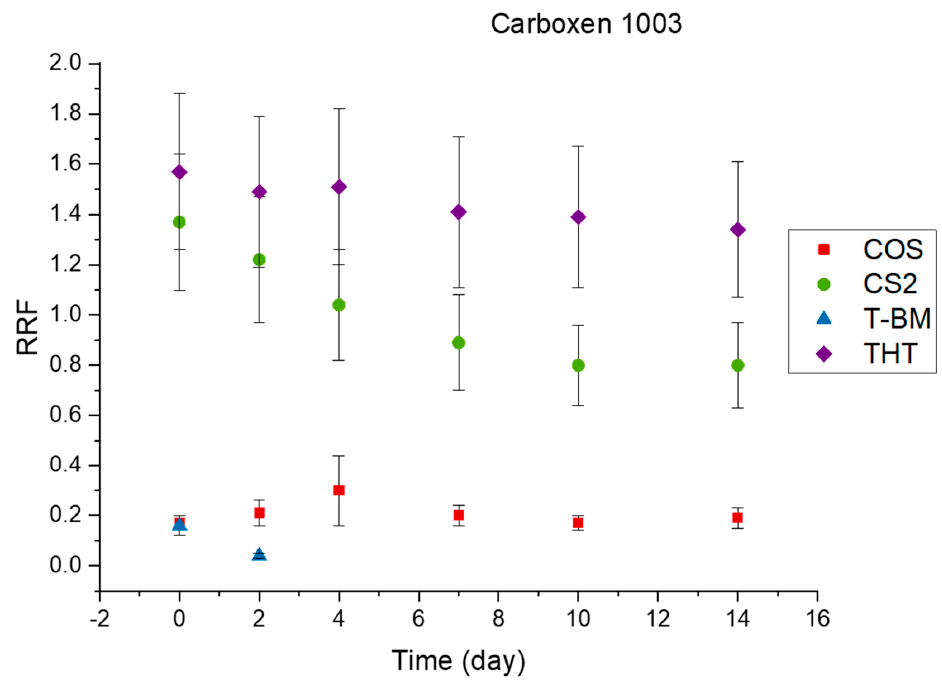
Figure 13. Storage stability of sulphur compounds (~20 nmol / mol) on Carboxen 1003.